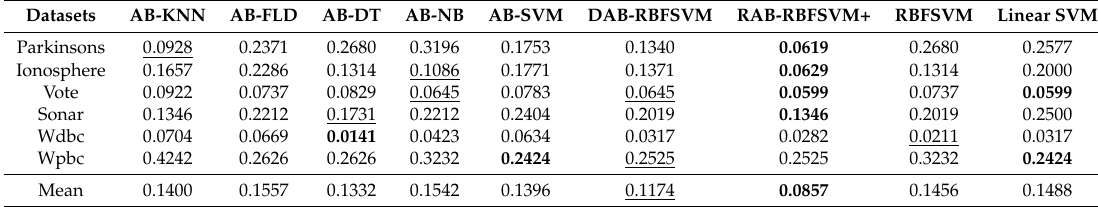
Table 5. Generation errors of different classifiers: AB-KNN, AB-FLD, AB-DT, AB-NB, AB-SVM, DAB-SVM, RAB-RBFSVM+ (For every single dataset, bold number gives the lowest error while underline number gives the second lowest